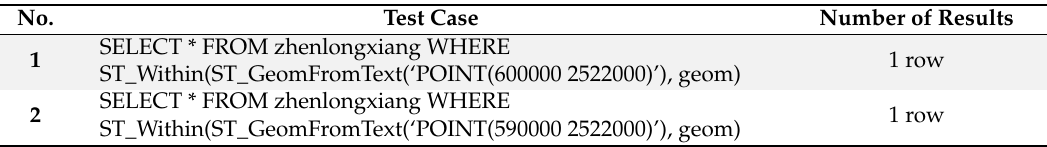
Table 8. Test cases of point queries.